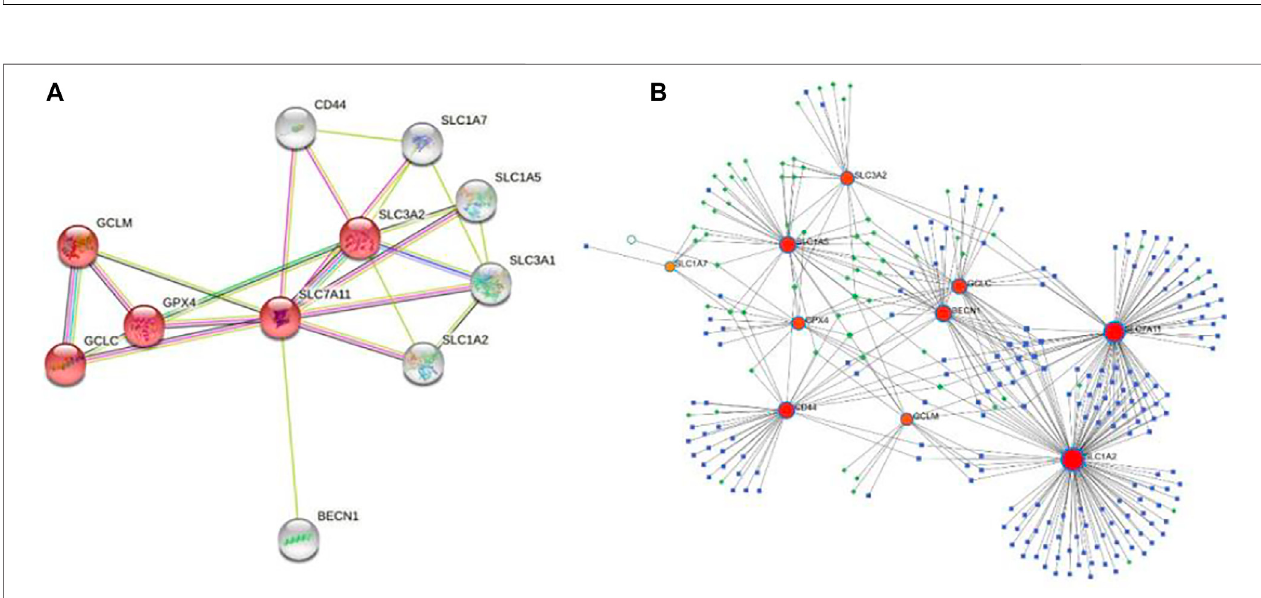
FIGURE 5 | PPI and the co-regulatory network of SLC7A11. (A) SLC7A11-interaction proteins in COAD tissue. The network consists of 11 nodes and 23 edges, the red nodes are involved in the ferroptosis signaling pathway. (B) TF-miRNA co-regulatory network. The network consists of 270 nodes and 397 edges. The nodes in red color are the co-expression genes, the blue nodes represent miRNA, the green nodes represent TFs, and the yellow nodes represent protein.